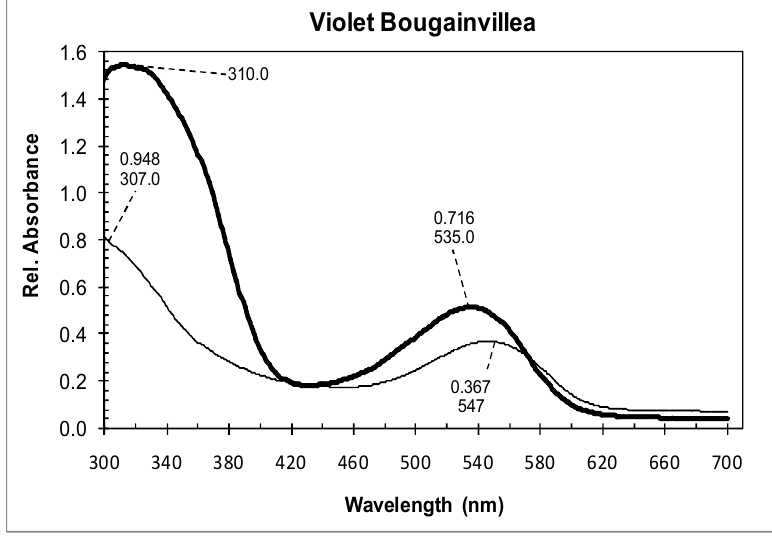
Figure 4. Absorption spectra of violet Bougainvillea spectabilis (VBS) extract (thick line) and violet Bougainvillea glabra (VBG) extract (thin line), both diluted in water at pH = 5.7.